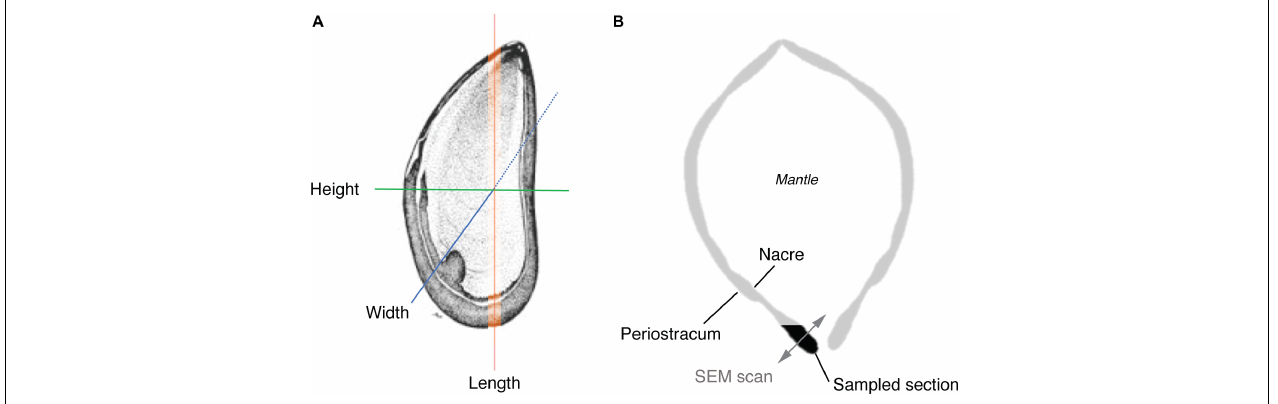
FIGURE 2 | Schematic illustrating (A) dimensional features (excluding volume) measured in the macro-morphometric study, and (B) transverse section of a mussel showing the location of the shell section used in EBSD analysis and direction of EBSD scans.